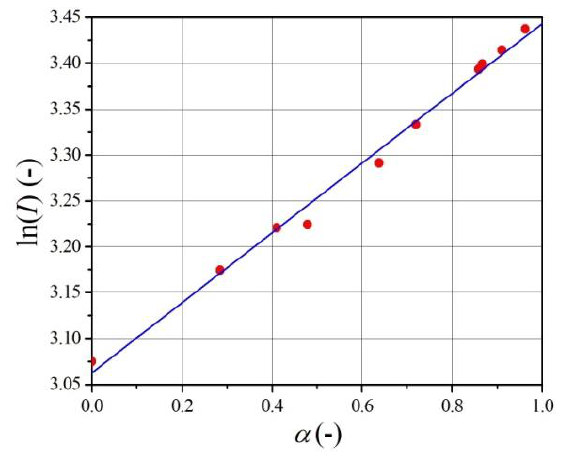
Fig. 6. The relationship between the natural logarithm of the gamma radiation intensity I (recorded by scintillation probe) and the void fraction  .